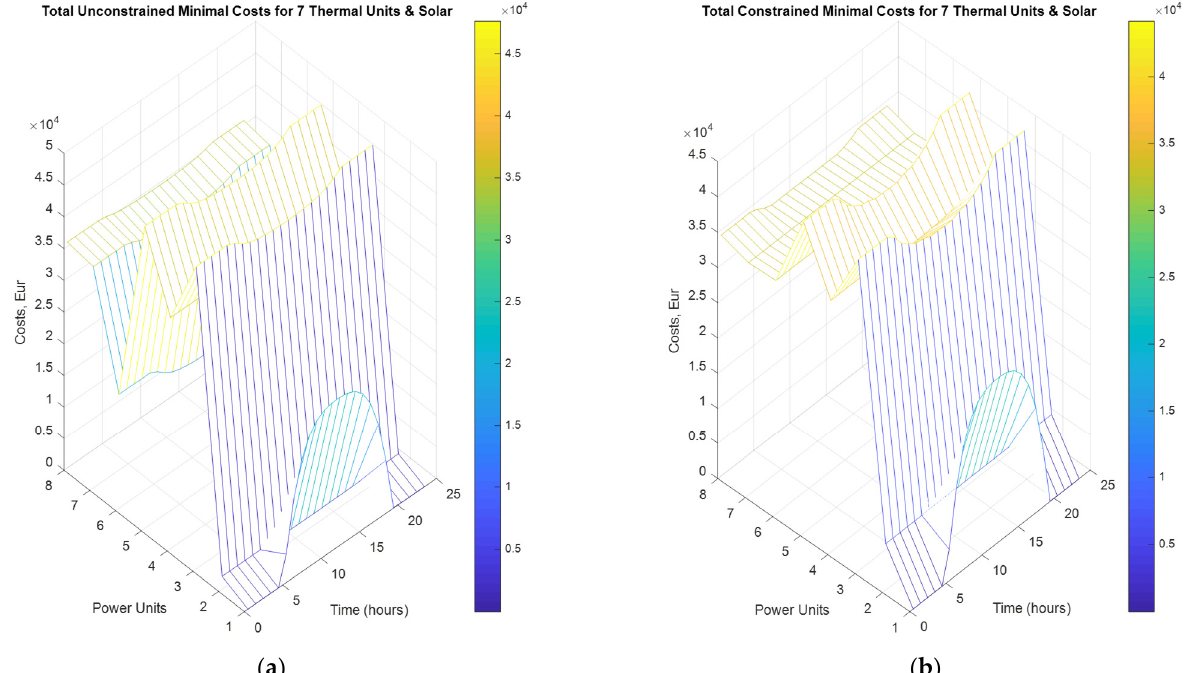
Figure 6. ( a ) Scenario 1: Total unconstrained minimal costs of seven thermal units and CSP over 24 h (CSP enabled); ( b ) Scenario 1: Total constrained minimal costs of seven thermal units and CSP over 24 h (CSP enabled).